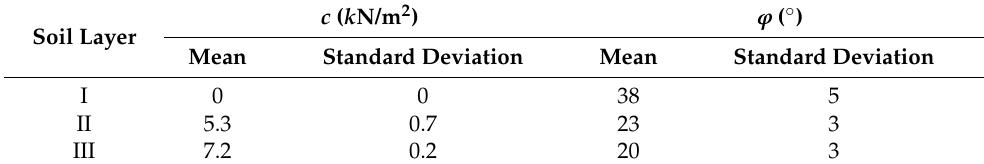
Figure 12. The relationship of running times and number samples. (I, II, III denote three different soil layers) Table 9. The statistics property of random variables.